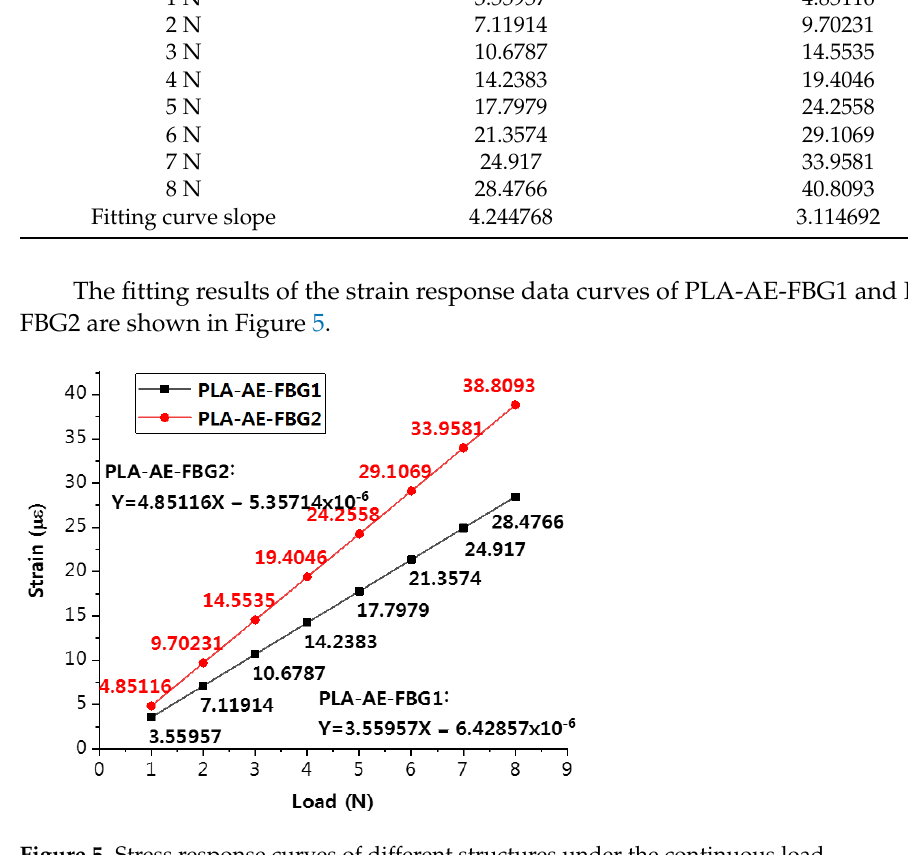
Figure 4. Stress contour plots of PLA-AE-FBG2. Table 1. Strain response data of PLA-AE-FBG1 and PLA-AE-FBG 2 under continuous load. LOAD